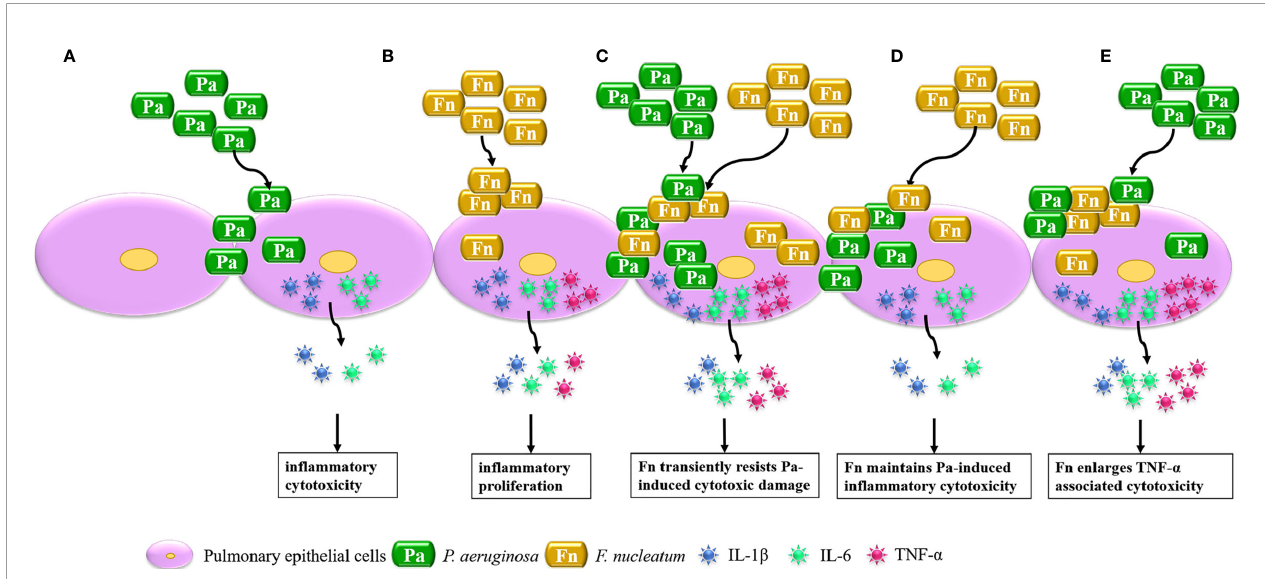
FIGURE 7 | Schematic diagram of the effect of mixed infection with P. aeruginosa and F. nucleatum on pulmonary epithelial cells based on the present model. (A) When pulmonary epithelial cells are infected with P. aeruginosa alone, P. aeruginosa induces IL-1 b and IL-6 associated in fl ammatory cytotoxicity of pulmonary epithelial cells. (B) When pulmonary epithelial cells are infected with F . nucleatum alone, F. nucleatum initiates high in fl ammatory proliferation of pulmonary epithelial cells. (C) When pulmonary epithelial cells are simultaneously infected with P. aeruginosa and F . nucleatum , F . nucleatum coaggregates with P. aeruginosa to synergistically invade into pulmonary epithelial cells and transiently resists P. aeruginosa -induced cytotoxic damage to induce over-release of IL-6 and TNF- a . (D) When pulmonary epithelial cells are pretreated with P. aeruginosa , F. nucleatum subsequential infection maintains P. aeruginosa -induced in fl ammatory cytotoxicity. (E) When pulmonary epithelial cells are pretreated with F. nucleatum , F. nucleatum pretreatment enlarged TNF- a associated cytotoxicity of pulmonary epithelial cells subsequentially infected with P. aeruginosa